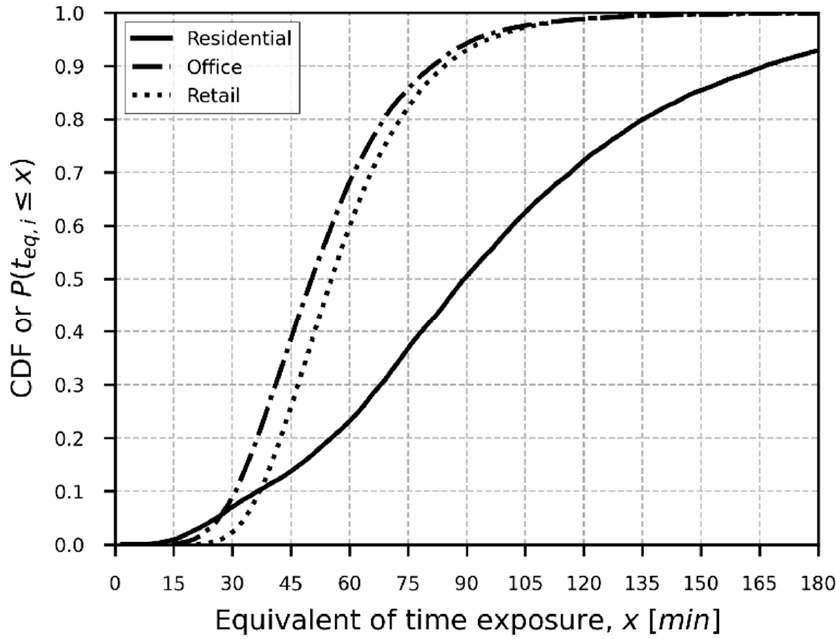
Figure 2. CDF of time equivalence solved from a MCS study using SFEPRAPY.